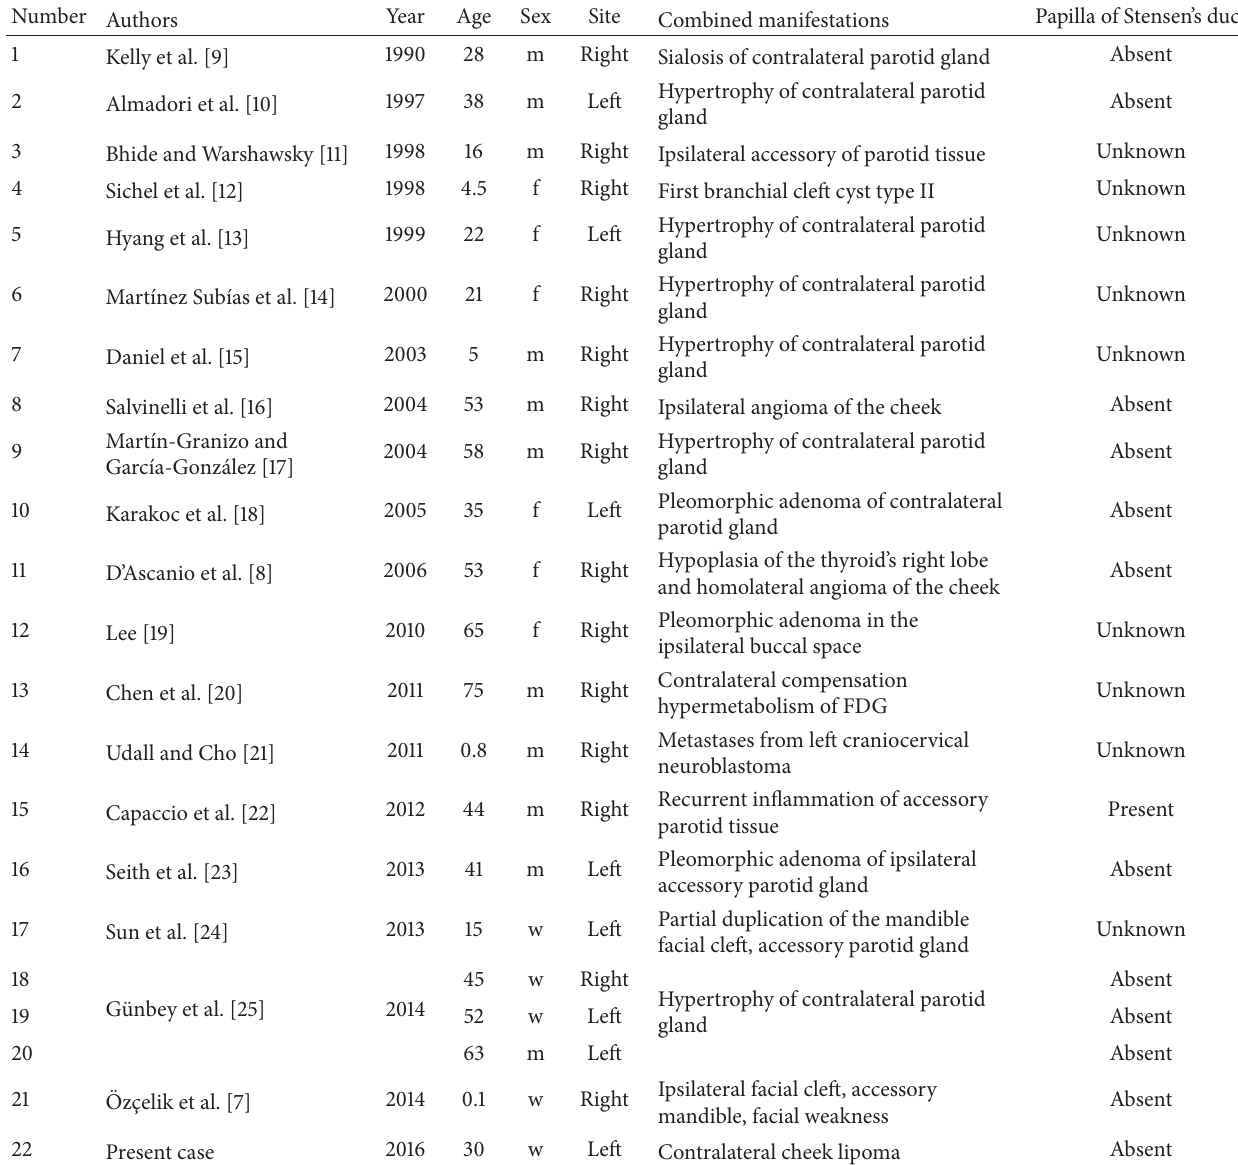
Table 1: Reported cases of unilateral parotid gland agenesis in the literature ( 𝑛 = 22